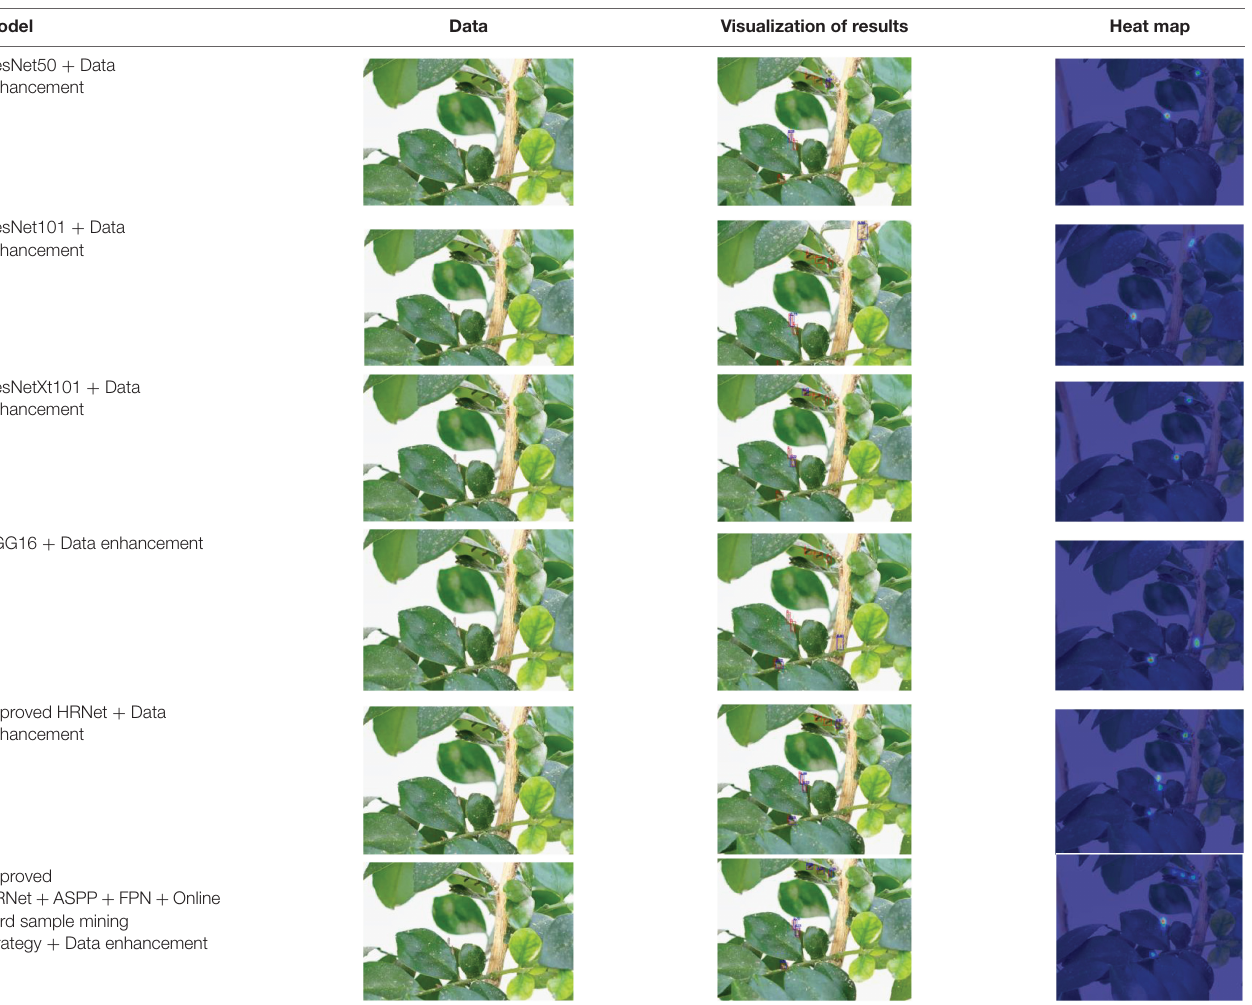
TABLE 2 | Visualization results of different